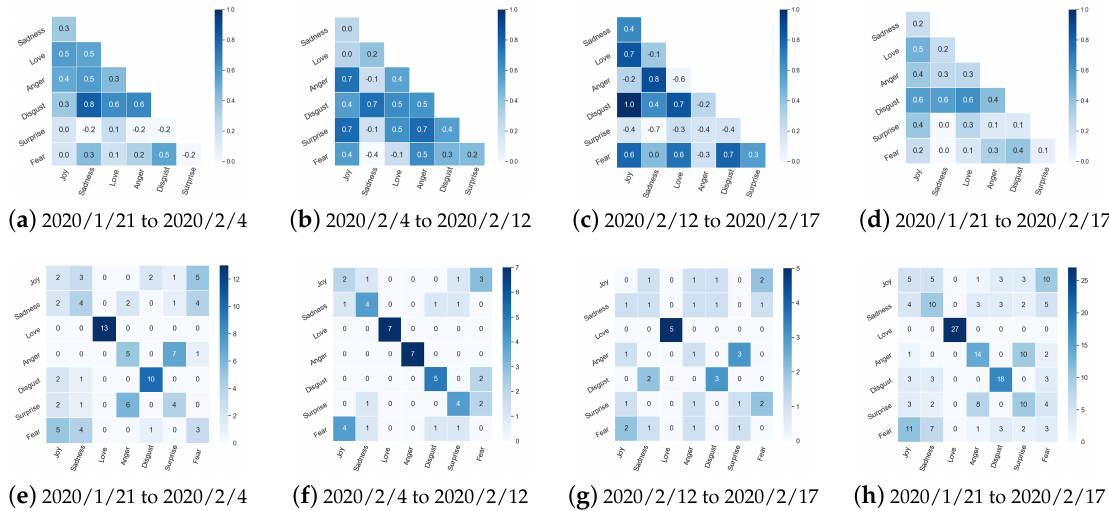
Figure 6. Public emotion covariance and transitions from 21 January 2020 to 17 February 2020, divided into three phases according to the peak/valley values of “newest confirmed cases of